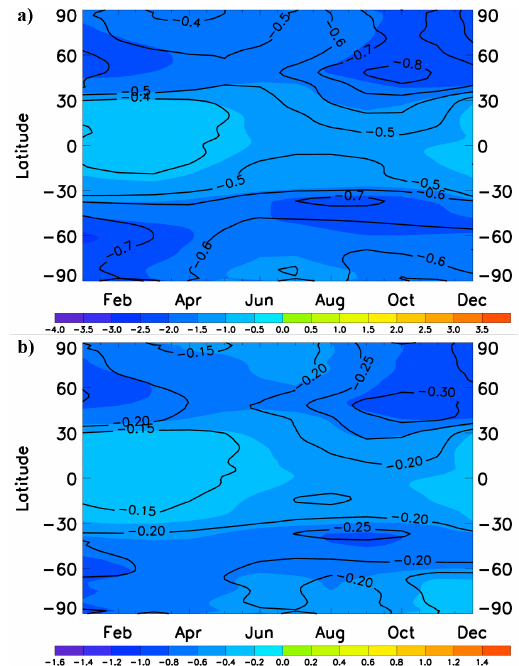
Fig. 1. 2050 zonal mean stratospheric column O 3 (shown by color in units of DU) and the increase from today’s atmosphere (a model run representing mid-1990s atmosphere) (shown by contours in units of DU) as a function of latitude and time of a year for (a) A1FI BL and (b) B1 BL scenarios.